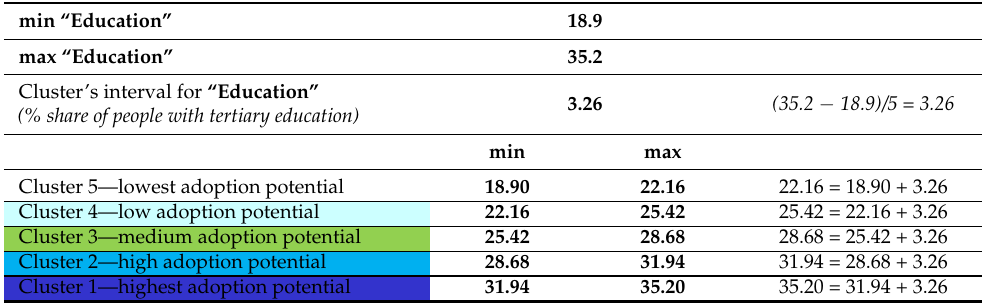
Table 5. Calculations for the “cluster interval” for variable “Education”. (% share of people with